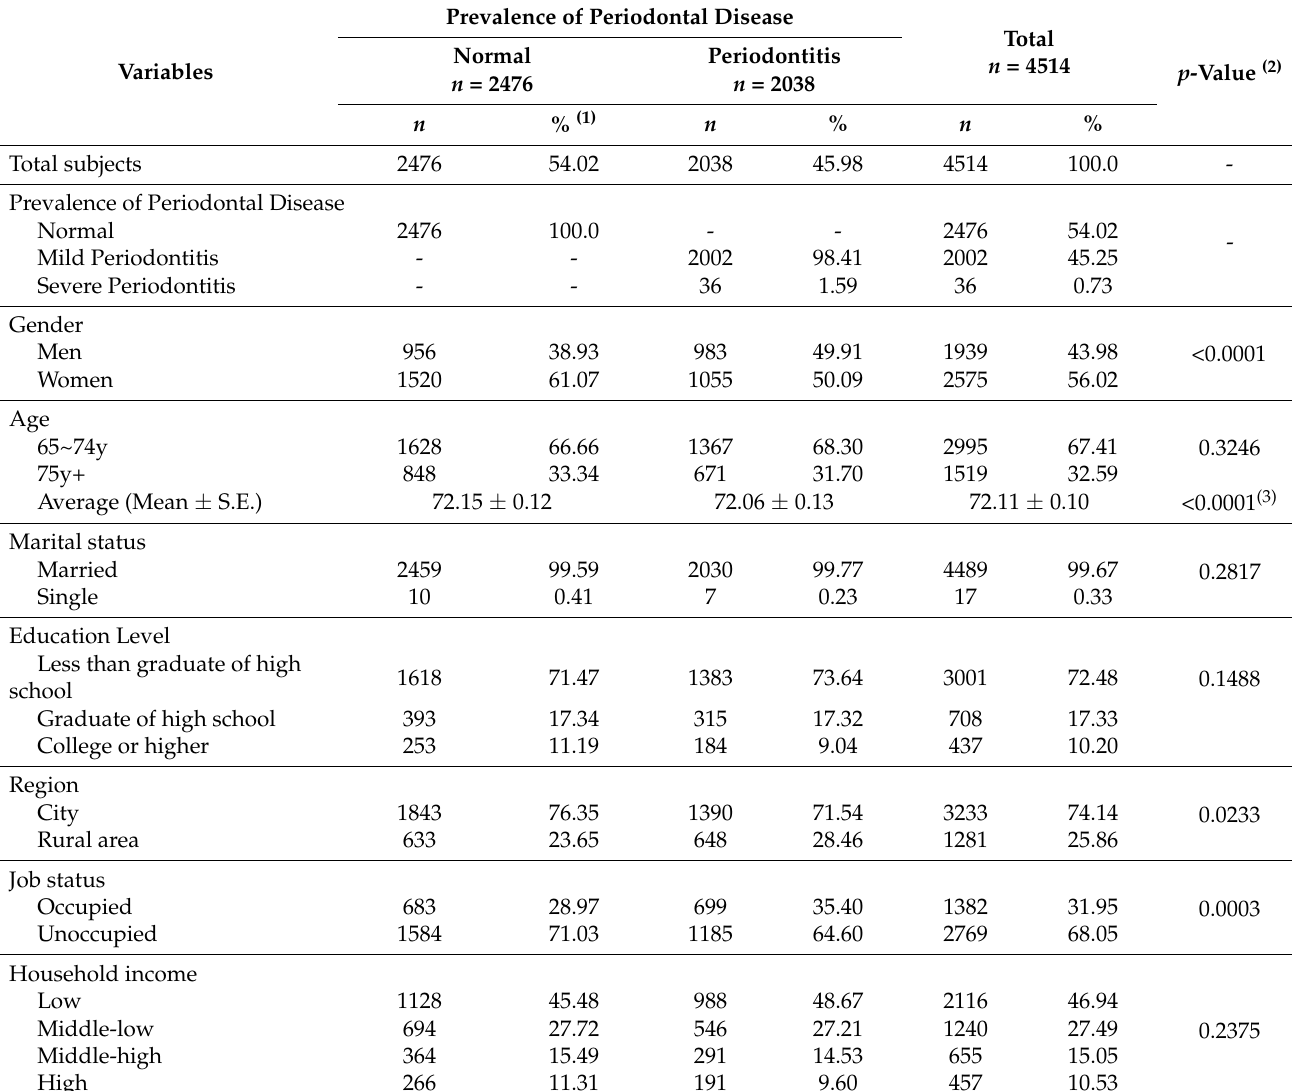
Table 1. General characteristics of